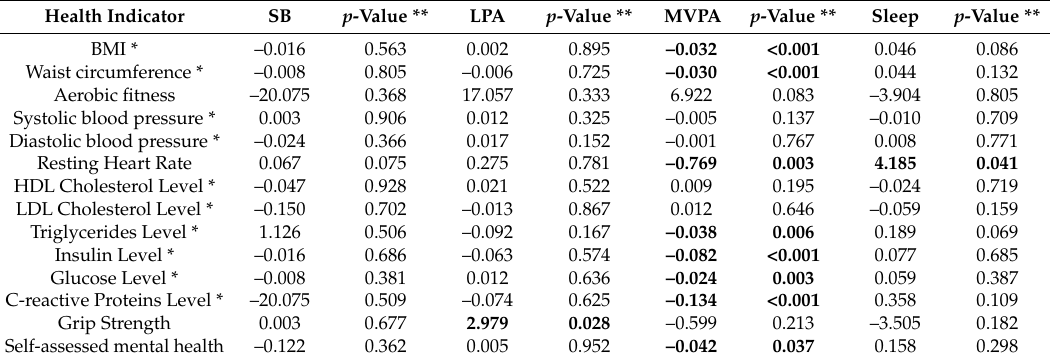
Table 2. Associations between health indicators and reallocations of time to individual components of the 24-h day from across the other components of the 24-h day for older adults (65–79